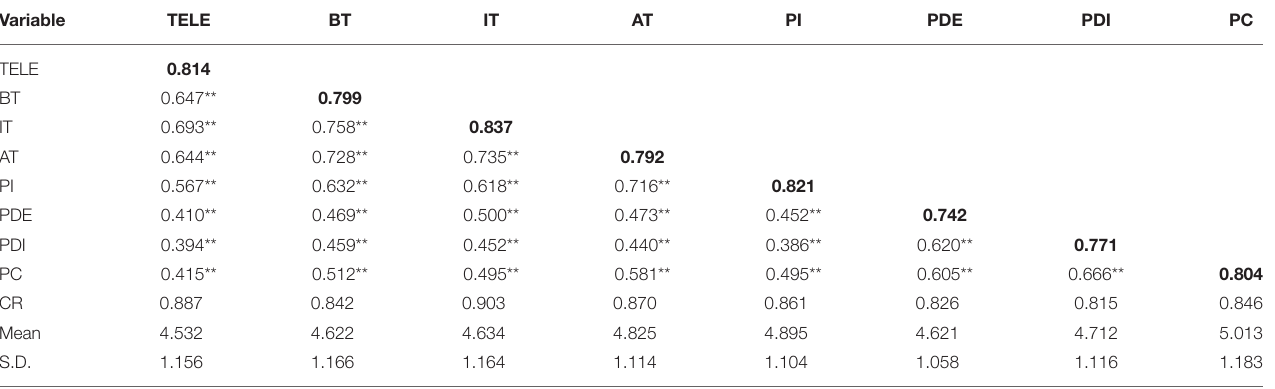
TABLE 2 | Descriptive statistics, correlation matrix and discriminant validity ( N = 406). Variable